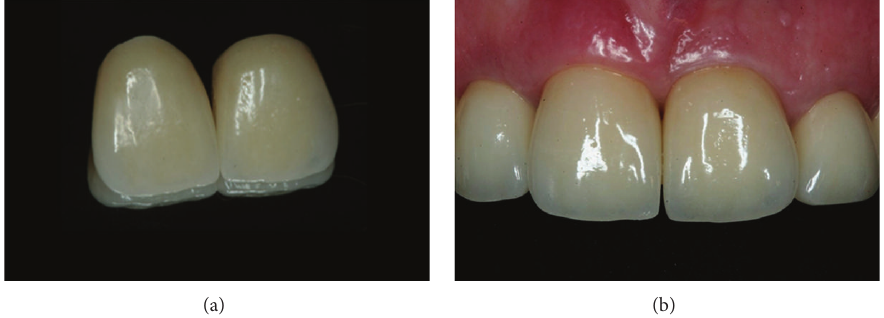
Figure 10: Buccal view of the implant crown and its excellent aesthetic results at a 12-month follow-up.